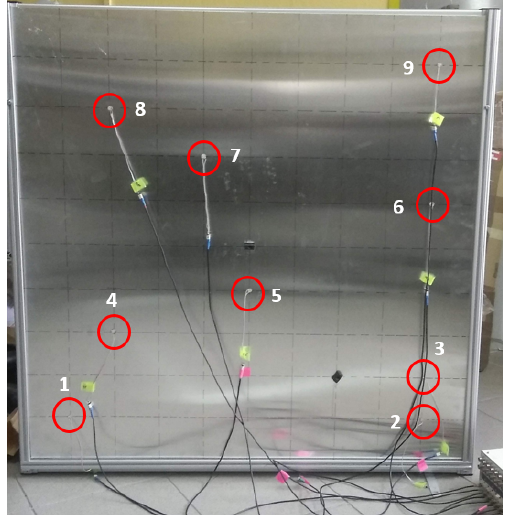
Figure 6. Aluminum plate with PZT